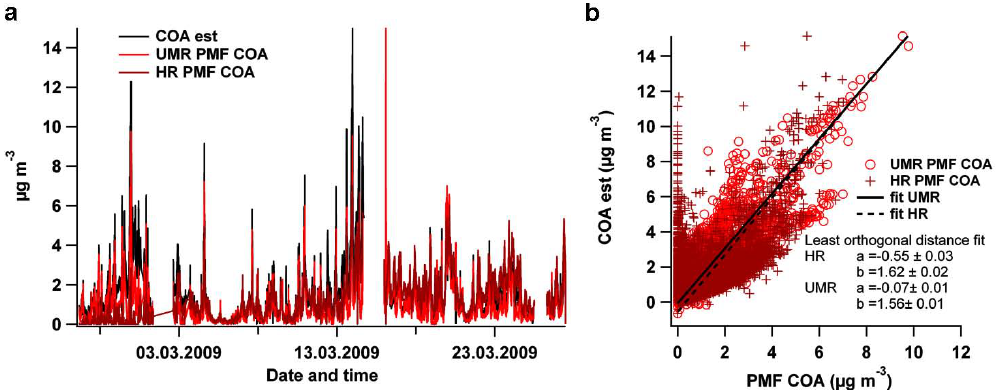
Fig. 8. Comparison of PMF COA and COA estimated using organic mass fragments 55, 57, and 44 (COA est), time series (a) and scatterplot of time series (b)